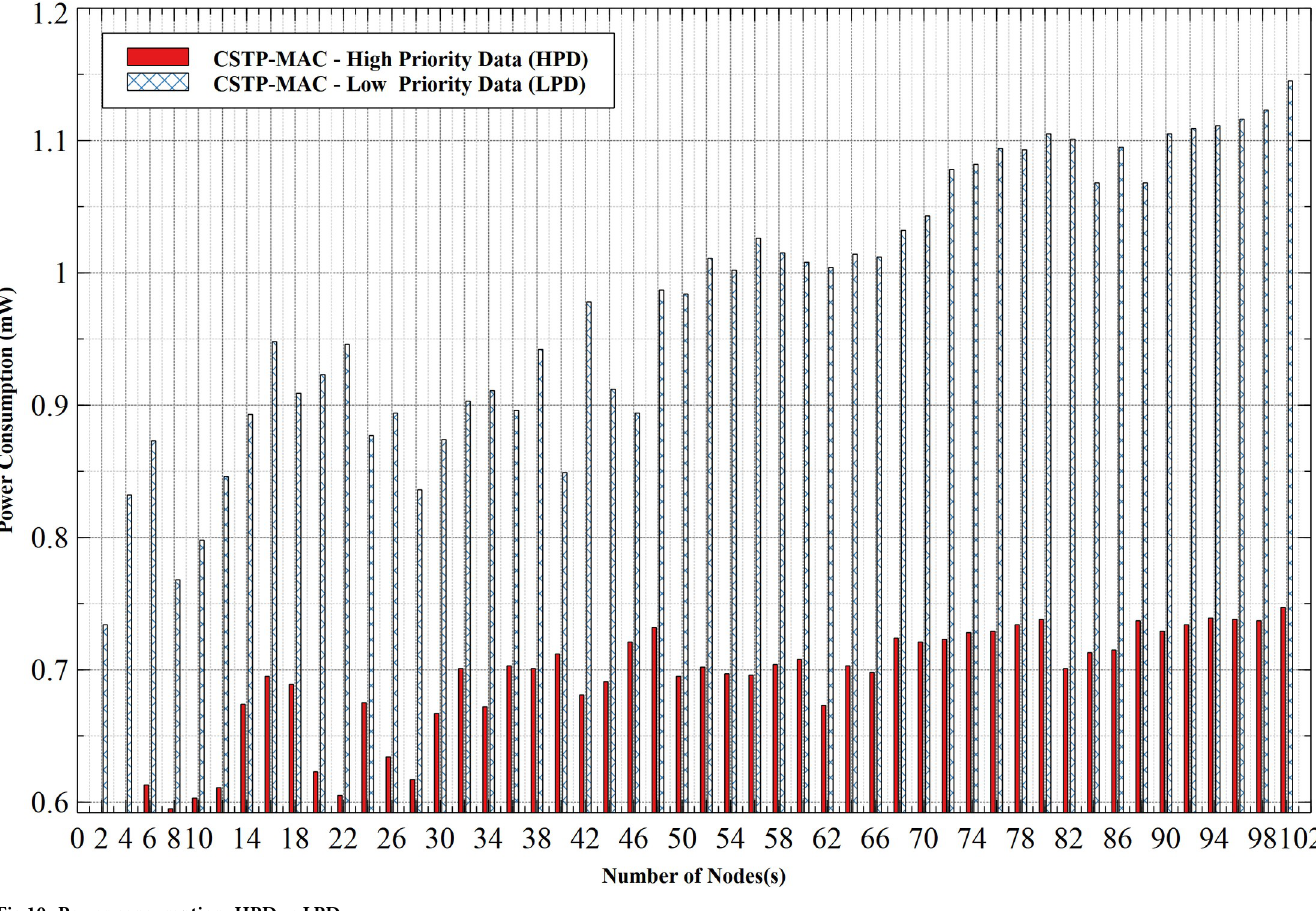
Fig 10. Power consumption–HPD vs